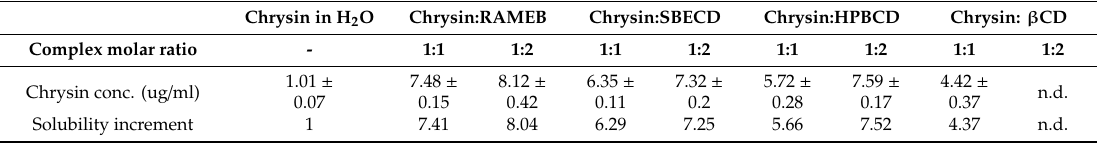
Table 1. Concentration values and solubility increment of chrysin in water by cyclodextrin complexation (n.d.—not determined) ( n = 3). β CD: β -cyclodextrin, HPBCD: hydroxypropyl- β -cyclodextrin, RAMEB: randomly-methylated- β -cyclodextrin, SBECD: Sulfobutylether- β